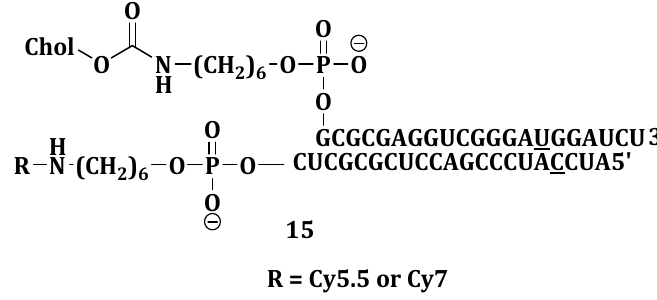
Figure 5. Structure of Chol-siMDR ( 15 ). 2’O-methyl nucleotides are underlined.